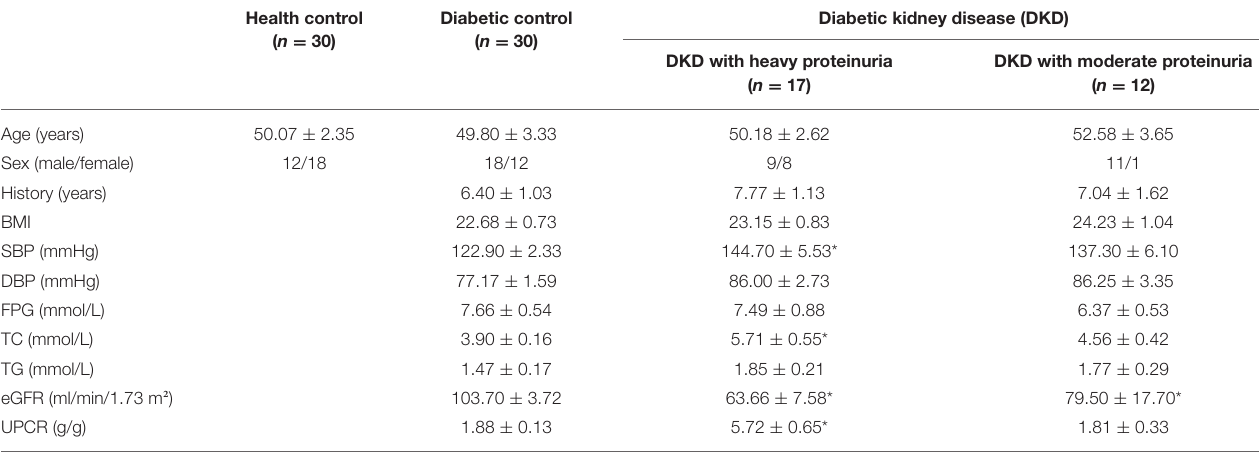
TABLE 1 | Laboratory and clinical characteristics of individuals included in the SCREENING cohort.